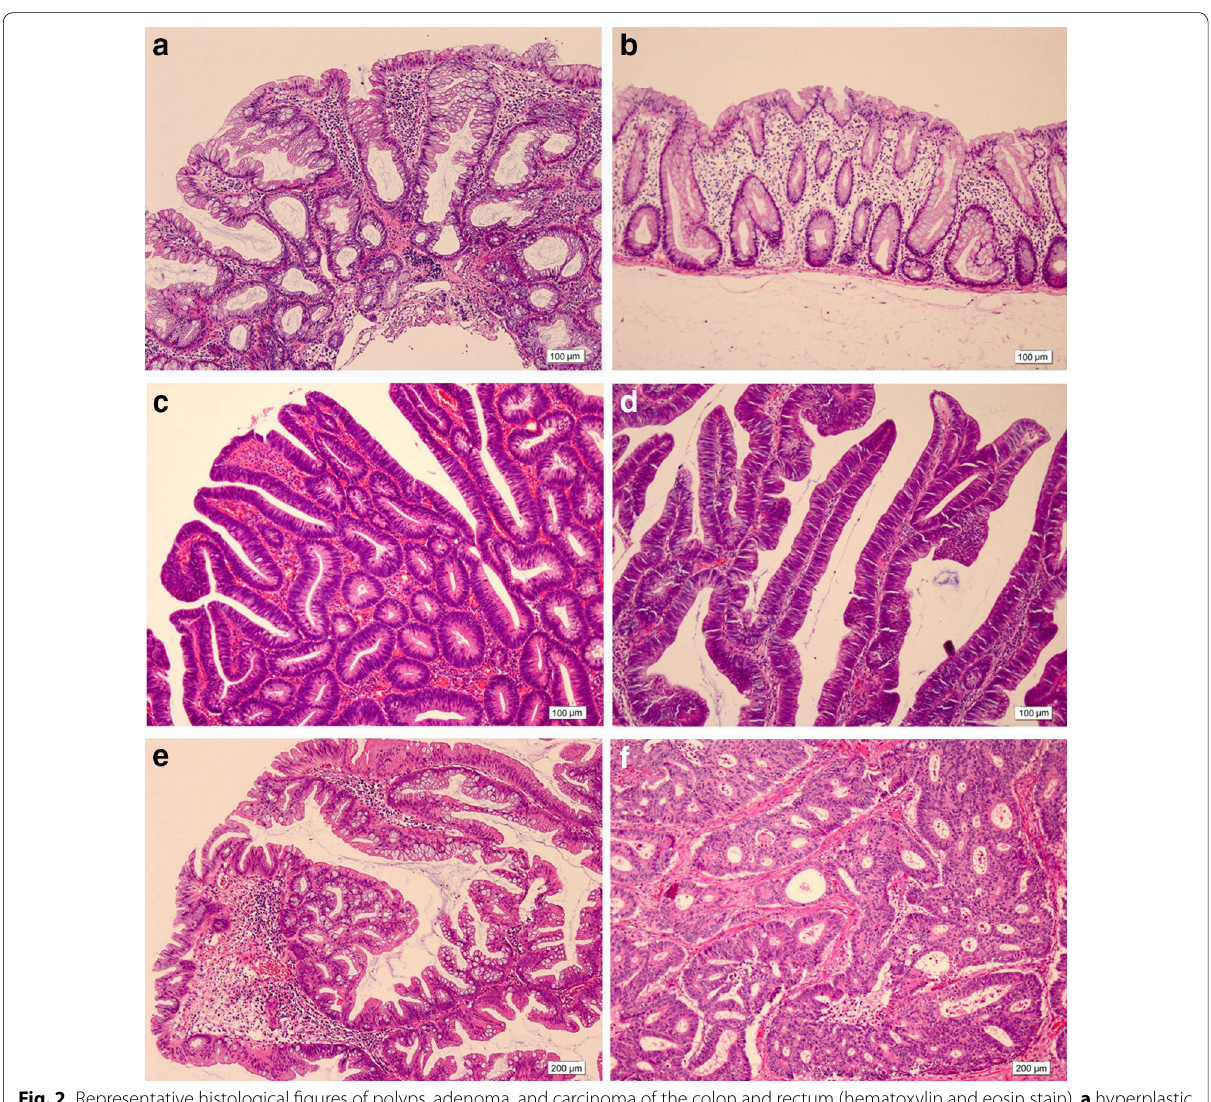
Fig. 2 Representative histological figures of polyps, adenoma, and carcinoma of the colon and rectum (hematoxylin and eosin stain). a hyperplastic polyp. b sessile serrated adenoma/polyp. c tubular adenoma. d villous adenoma. e traditional serrated adenoma. f